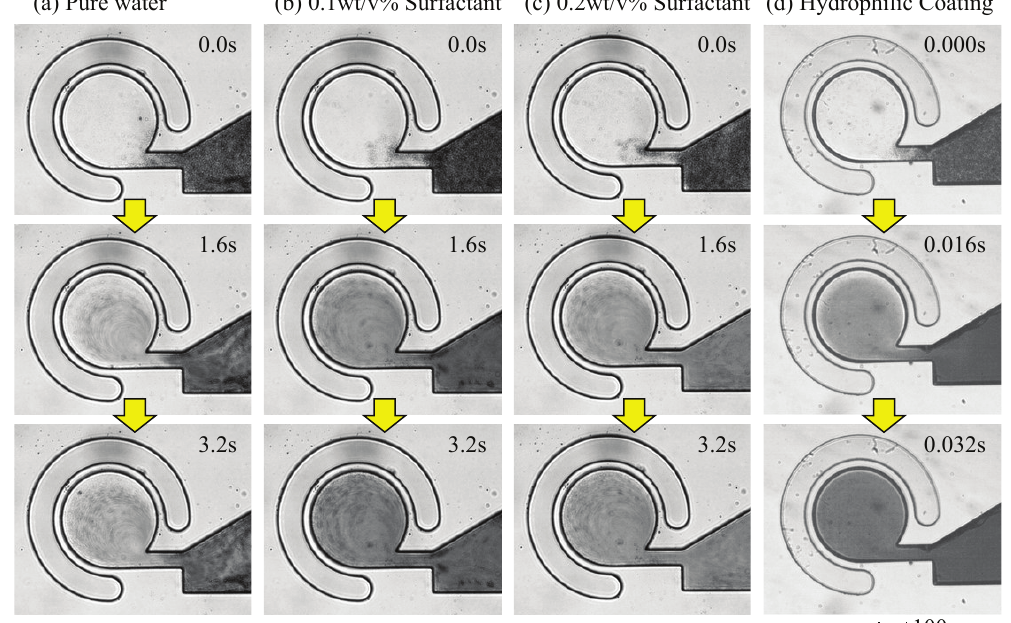
Figure 6. Captured images of the mixing experiment. ( a ) Results of pure water. ( b ) Results of 0.1 wt/v% of surfactant. ( c ) Results of 0.2 wt/v% of surfactant. ( d ) Results of hydrophilic coated channel.